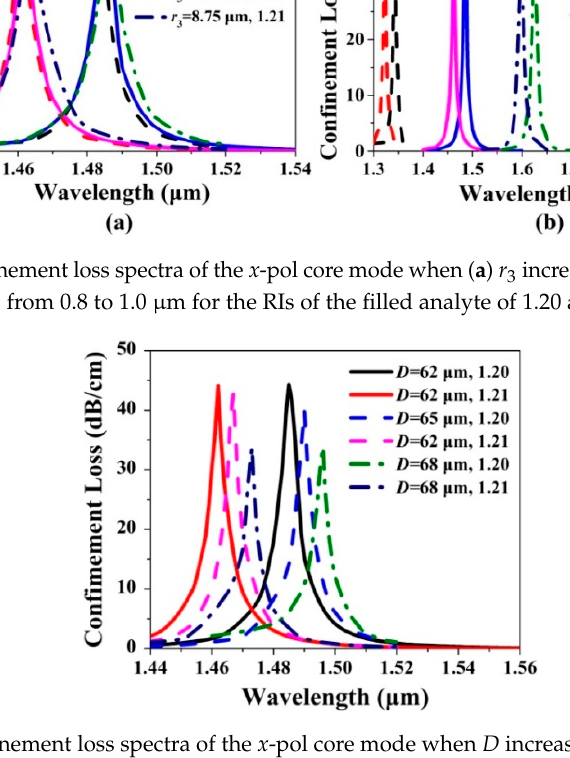
Figure 5. The confinement loss spectra of the x -pol core mode when ( a ) r 3 increases from 7.75 to 8.75 μ m and ( b ) t 3 increases from 0.8 to 1.0 μ m for the RIs of the filled analyte of 1.20 and 1.21, respectively.